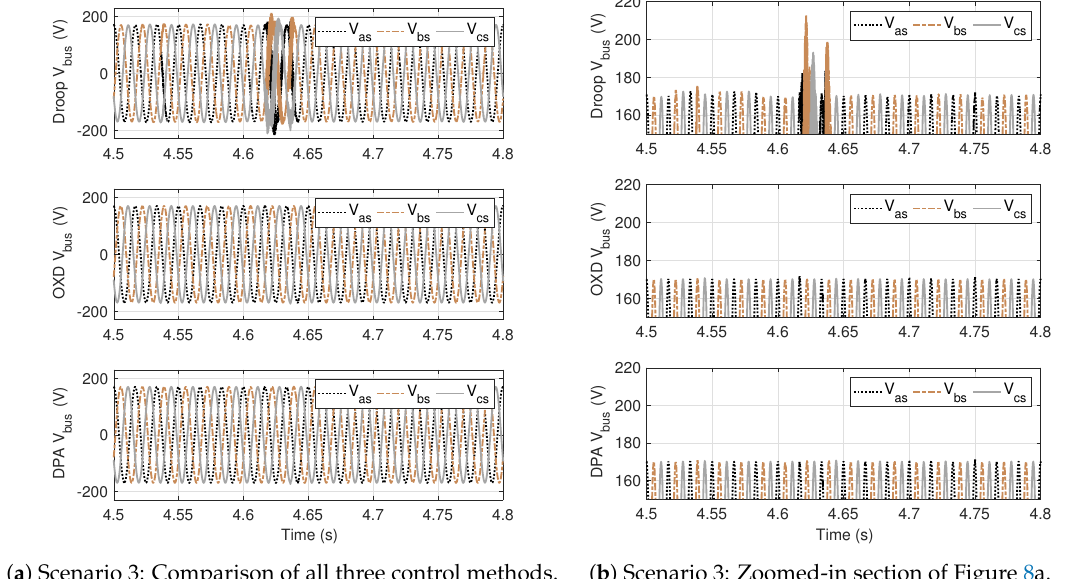
( b ) Scenario 3: Zoomed-in section of Figure 8a. V droop, OXD, and DPA ω / Q − − V droop, in terms of abc bus voltage ω / Q − −